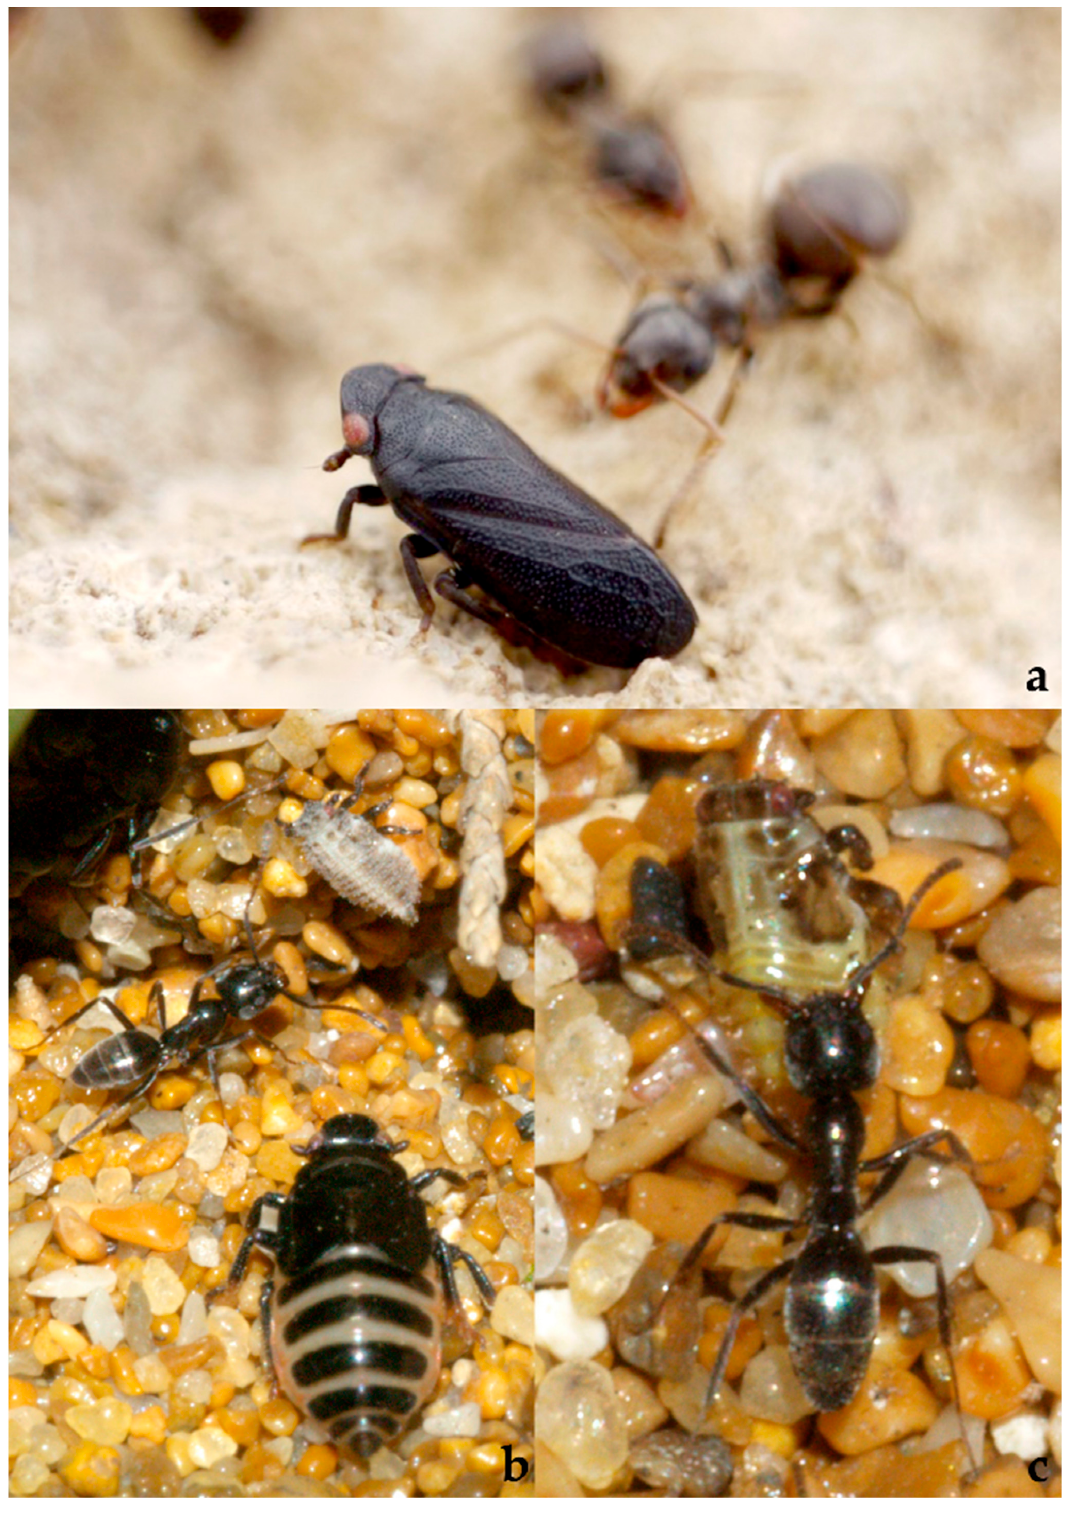
Figure 29. Tettigometridae: ( a ) Tettigometra ( Tettigometra ) fusca Fieber, 1865 tended by Formicidae indet., Ukraine: Mykolayiv, 46°58 ′ 30.1 ″ N 31°59 ′ 40.5 ″ E, 17.03.2019, adults, obs. Roman (efarilis); ( b , c ) T. ( Tettigometra ) impressifrons Mulsant and Rey, 1855 tended by Formicidae: Dolichoderinae: Tapinoma sp., Italy: Calabria, Capo Colonna, 39°0 ′ 46 ″ N 17°10 ′ 49 ″ E, 27.04.2008, nymphs and adults on Cakile maritima Scopoli (Brassicaceae), obs. I. Gjonov, A. Lapeva-Gjonova.